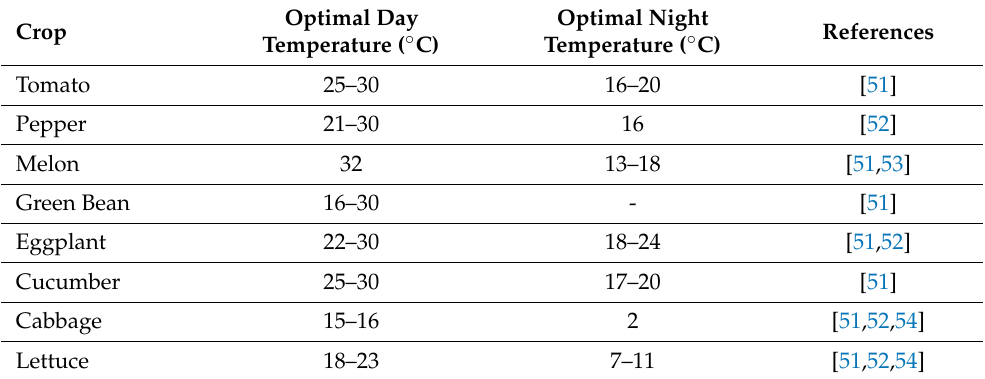
Table 2. Temperature requirements for selected greenhouse